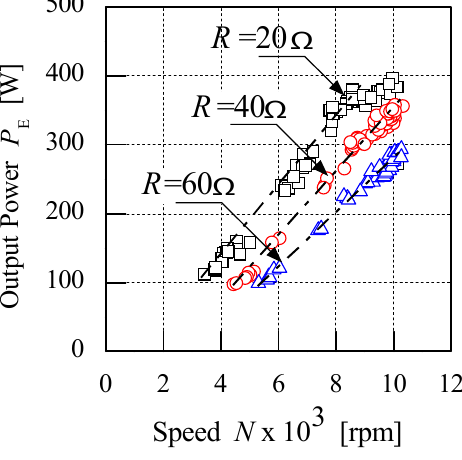
Figure 6. Relationship between electrical output power and engine